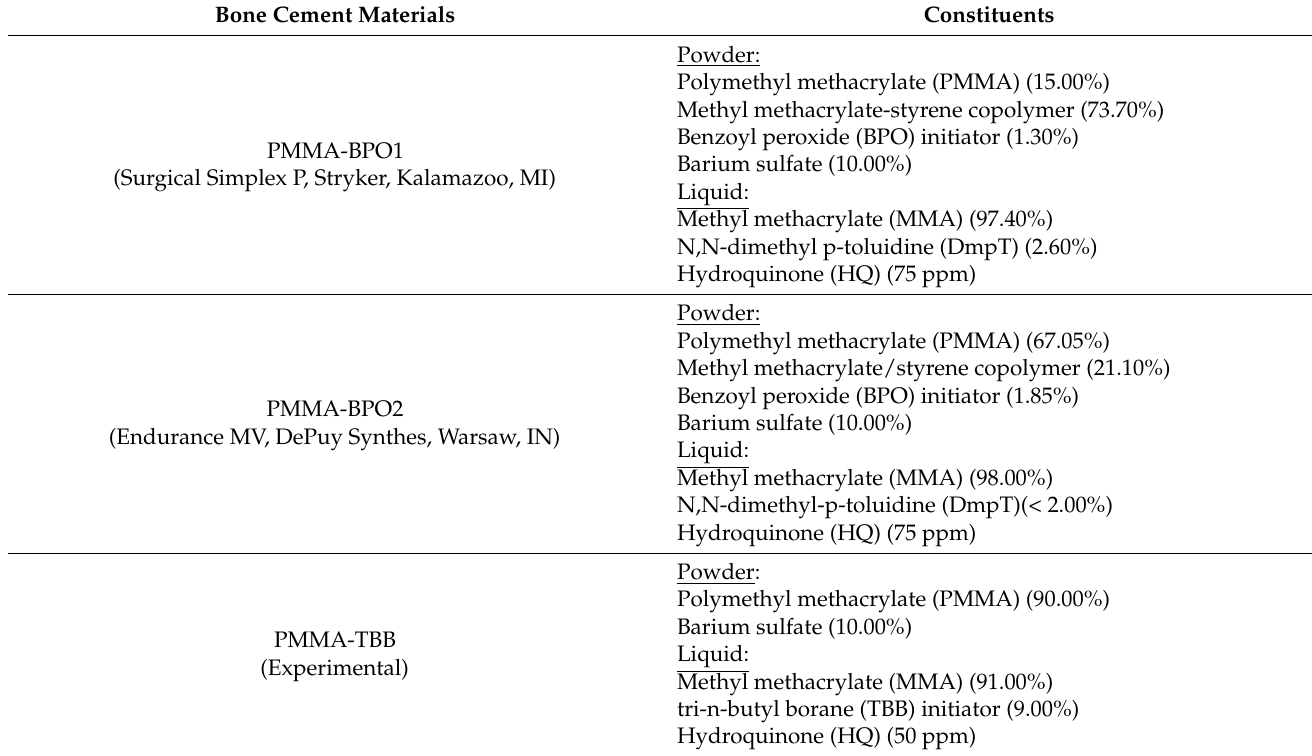
Table 1. The constituents of three different bone cement materials used in this study. Bone Cement